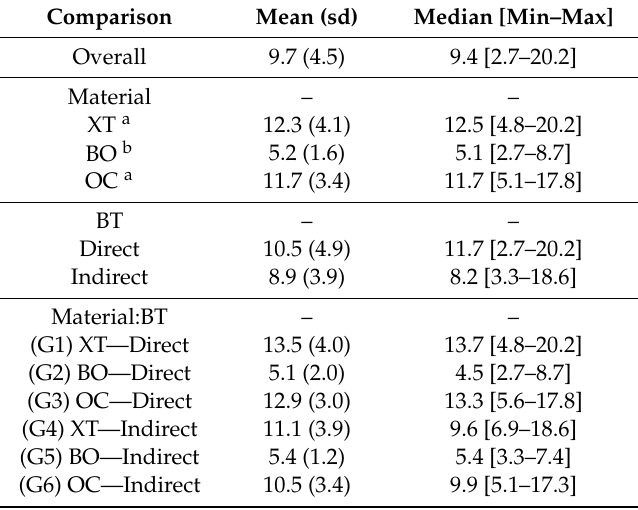
Table 3. Descriptive values of shear bond strength for the overall sample, levels of two factors, and the six study